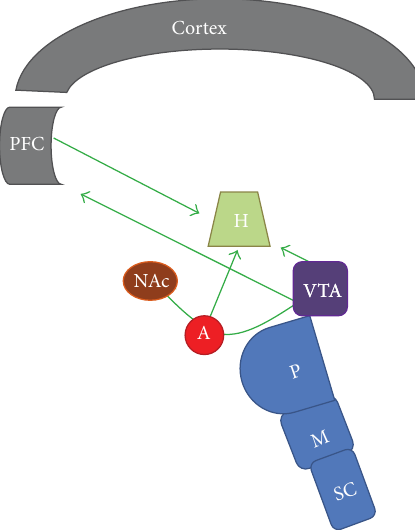
Figure 1: The dopaminergic pathways involved in food control. Dopamine neurons in the VTA send axonal projections to H, A, NAc, and PFC. The projections of the dopaminergic system from A and PFC to LH are directly involved in the regulation of food intake regulation. SC: spinal cord; M: medulla oblongata; VTA: ventral tegmental area; PFC: prefrontal cortex; A: amygdala; NAc: nucleus accumbens; H: